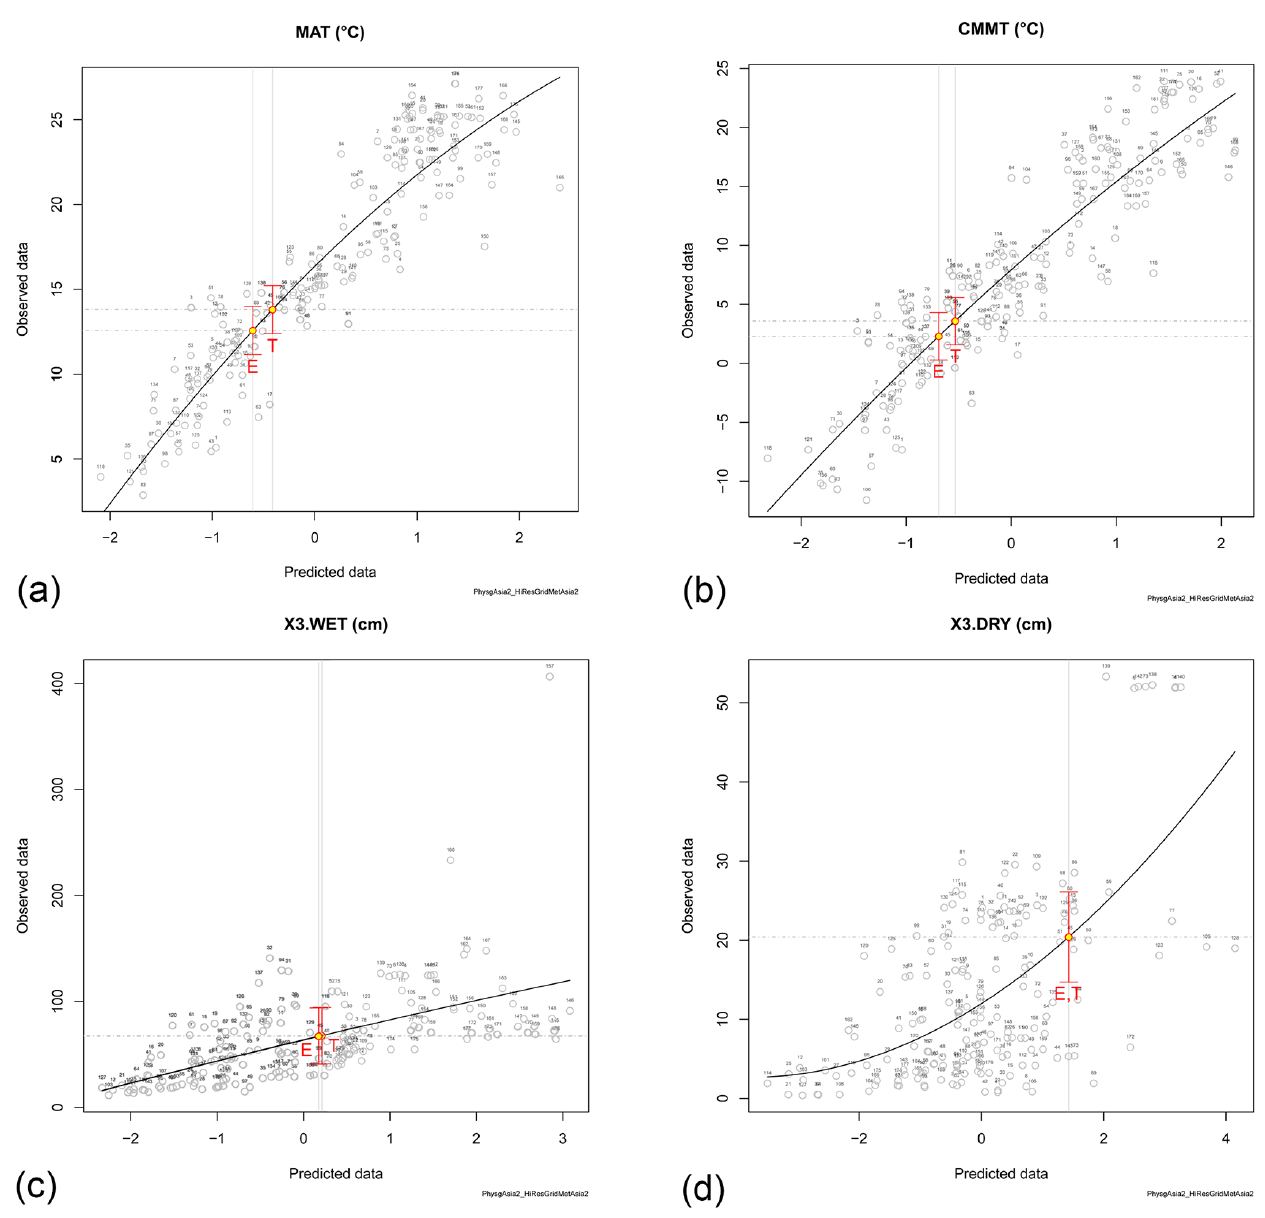
Figure 6. CLAMP climate inference for the macrofossil assemblage of (E) Eskihisar and (T) Tınaz (same level as PZ 2). (a) Mean annual temperature (MAT). (b) Coldest-month mean temperature (CMMT). (c) Precipitation of the 3 wettest months. (d) Precipitation of the 3 driest